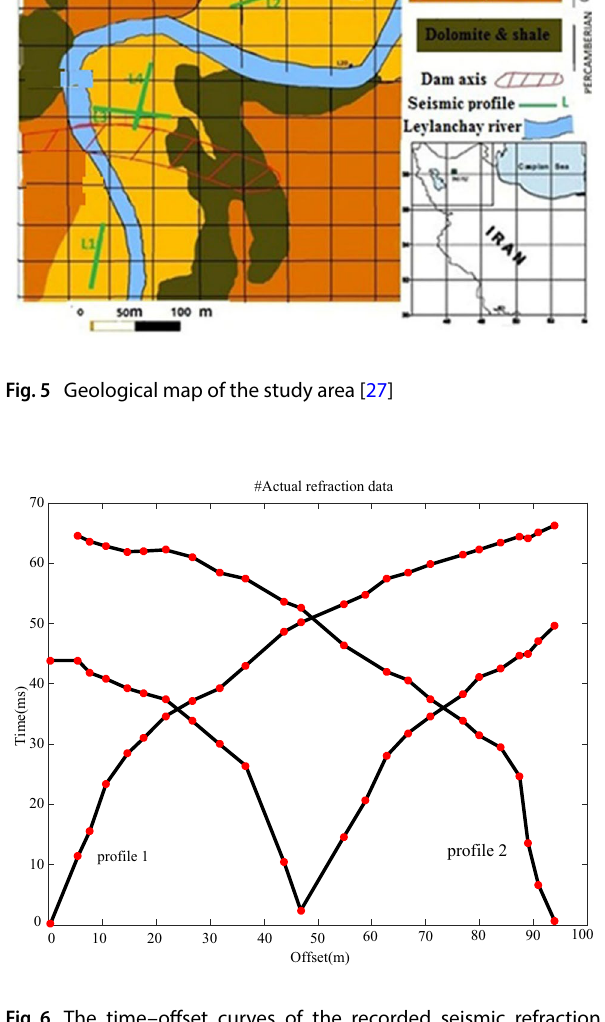
Fig. 6 The time–offset curves of the recorded seismic refraction data in the study